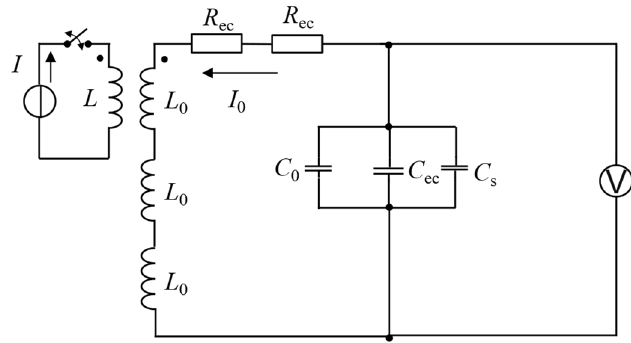
Figure 3. Equivalent electrical circuit for EMAT receiving process.